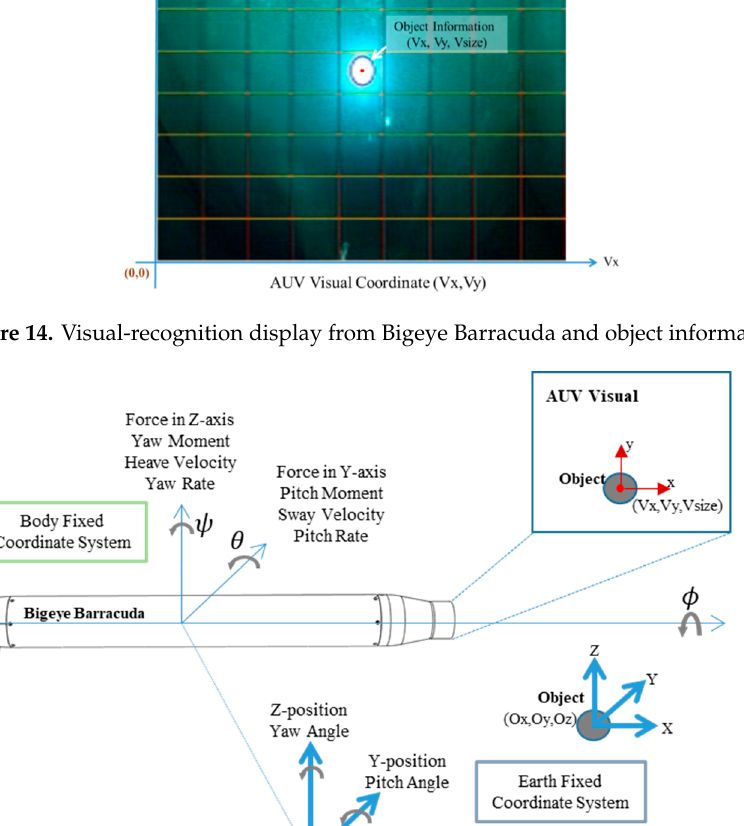
Figure 15. Schematics of the visual, body-fixed, and Earth-fixed coordinate systems.